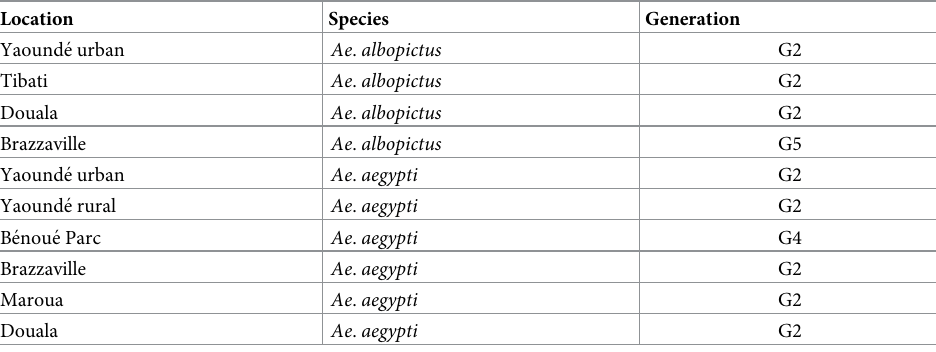
Table 1. Origin of Ae . aegypti and Ae . albopictus used for vector competence.